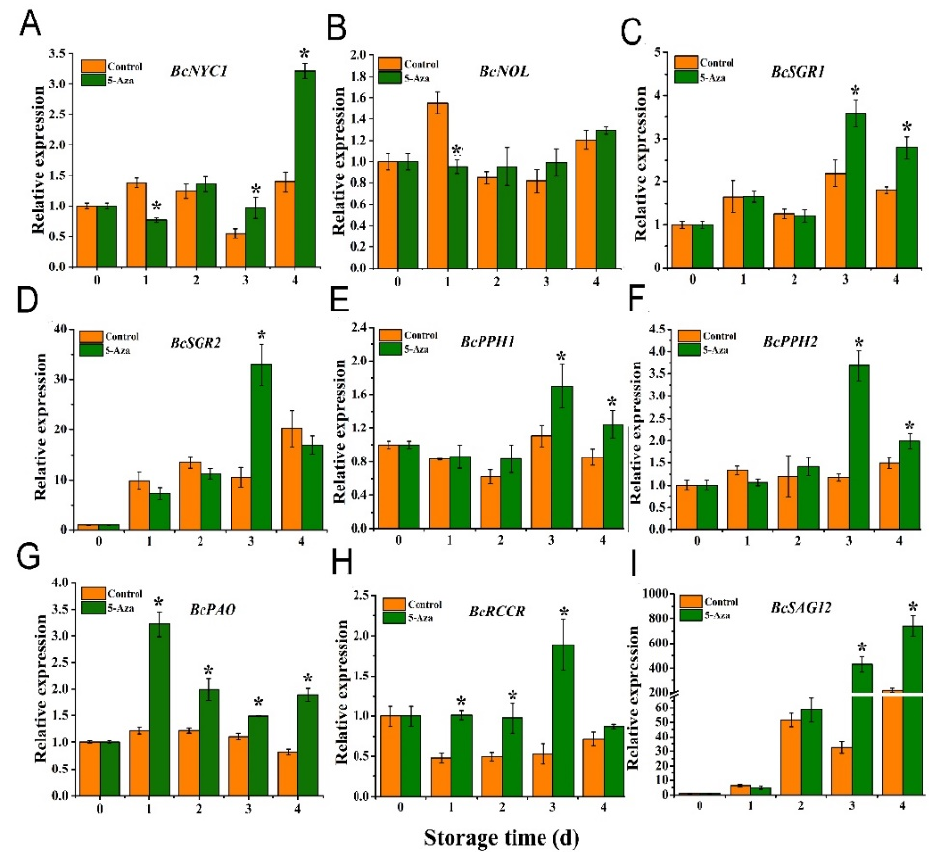
Figure 6. The detected expression levels of the eight Chl degrading genes ( BcNYC1, BcNOL, BcSGR1, BcSGR2 , BcPPH1 , BcPPH2 , BcPAO , and BcRCCR ) ( A – H ) and the senescence marker gene ( BcSAG12 ) BcSGR2, BcPPH1, BcPPH2, BcPAO , and BcRCCR ) ( A – H ) and the senescence marker gene ( BcSAG12 ) ( I ) in pak choiat 20 ± 1 ◦ C. The data in the figure are the mean ± SD of three biological ( I ) in pak choiat 20 ± 1 °C. The data in the figure are the mean ± SD of three biological replicates. The